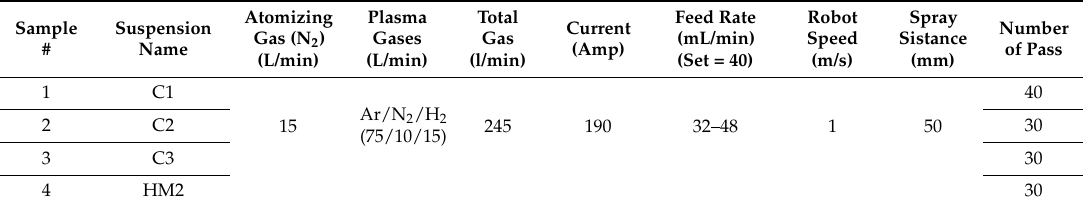
Table 3. Spray conditions using Axial III with axial injection and